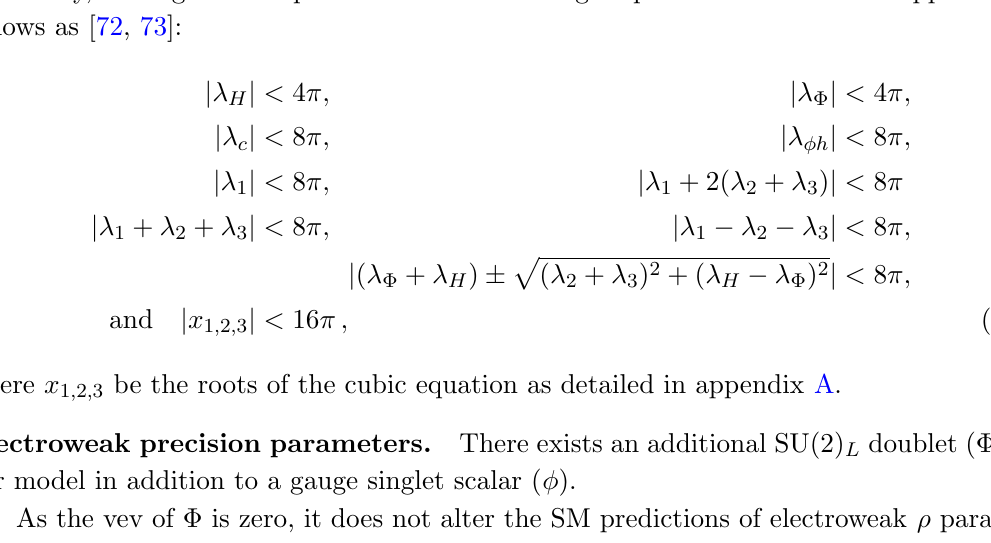
Figure 2 . Constraints from (cid:1) S (left) and (cid:1) T (right) in m (cid:1) S , we have taken 1 (cid:27) limit for two di(cid:11)erent choices of m show both 1 (cid:27) and 2 (cid:27) limits for a range of m Tree level